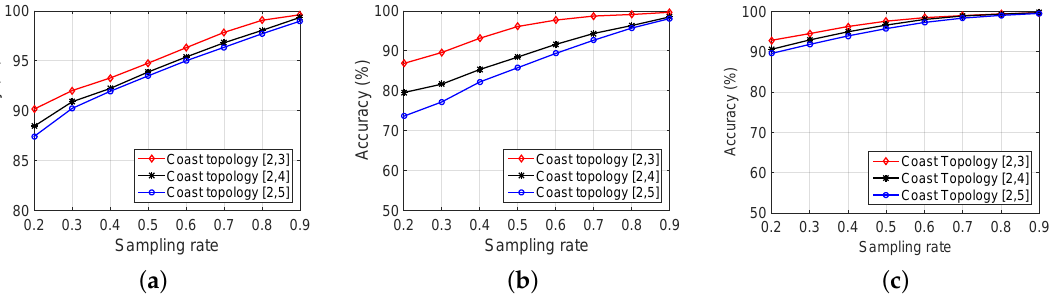
Figure 15. Evaluation of performance in the coast topology: ( a ) link quality reconstruction accuracy in the coast topology; ( b ) routing path reconstruction accuracy in the coast topology; and ( c ) topology reconstruction accuracy in the coast